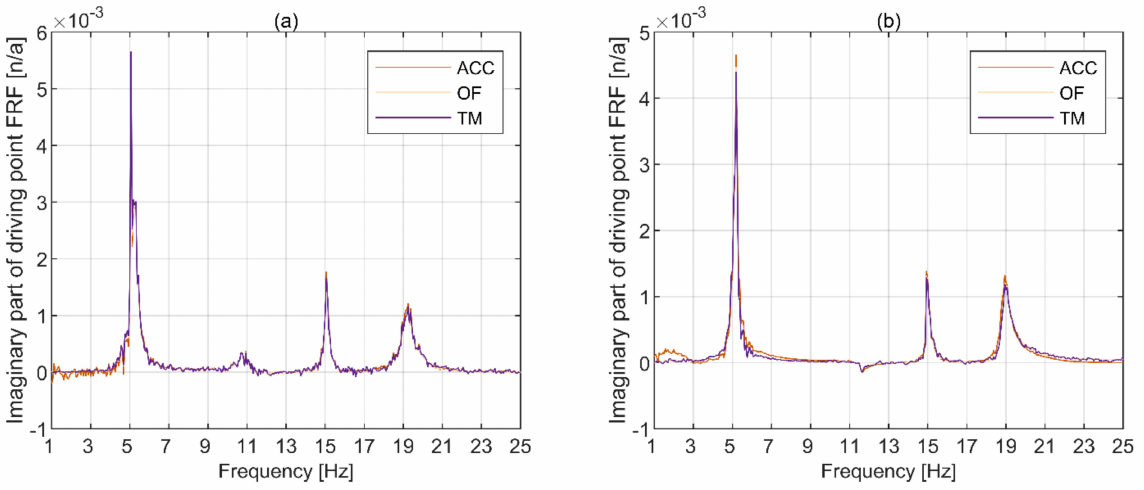
Figure 7. Imaginary part of driving point accelerance FRF from ( a ) T2 and ( b )